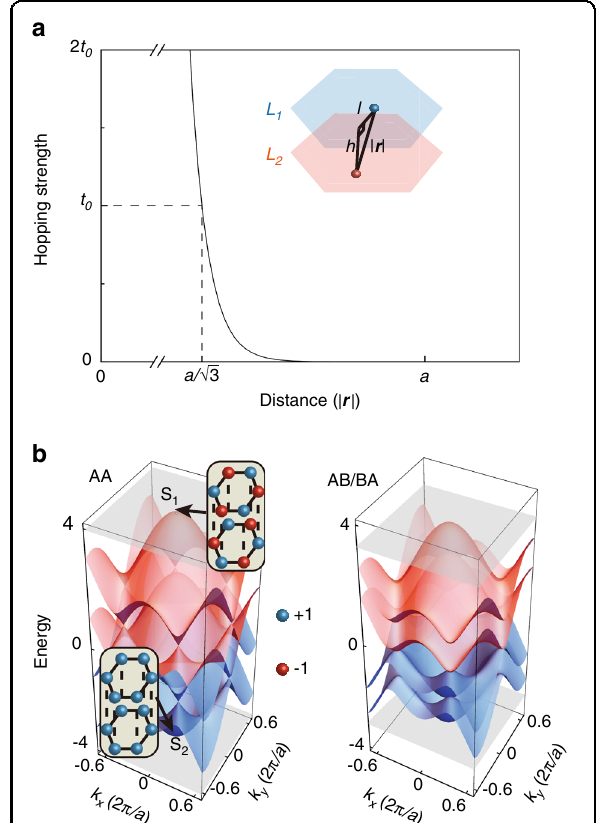
Fig. 2 Generic hopping function and band structures of AA and AB/BA stacked lattices. a Hopping strength function that decays exponentially with the independent variable of site-to-site distance r , where only the nearest-neighbor hoppings for intralayer sites are considered. b Rigorous band structures of AA and AB/BA stacked ffiffiffi p lattices calculated by the TBM with h ¼ a = 3 . The insets show the fi eld distributions of S 1 (highest energy) and S 2 (lowest energy) located at Γ point, implying C 3 and C 6 symmetries,